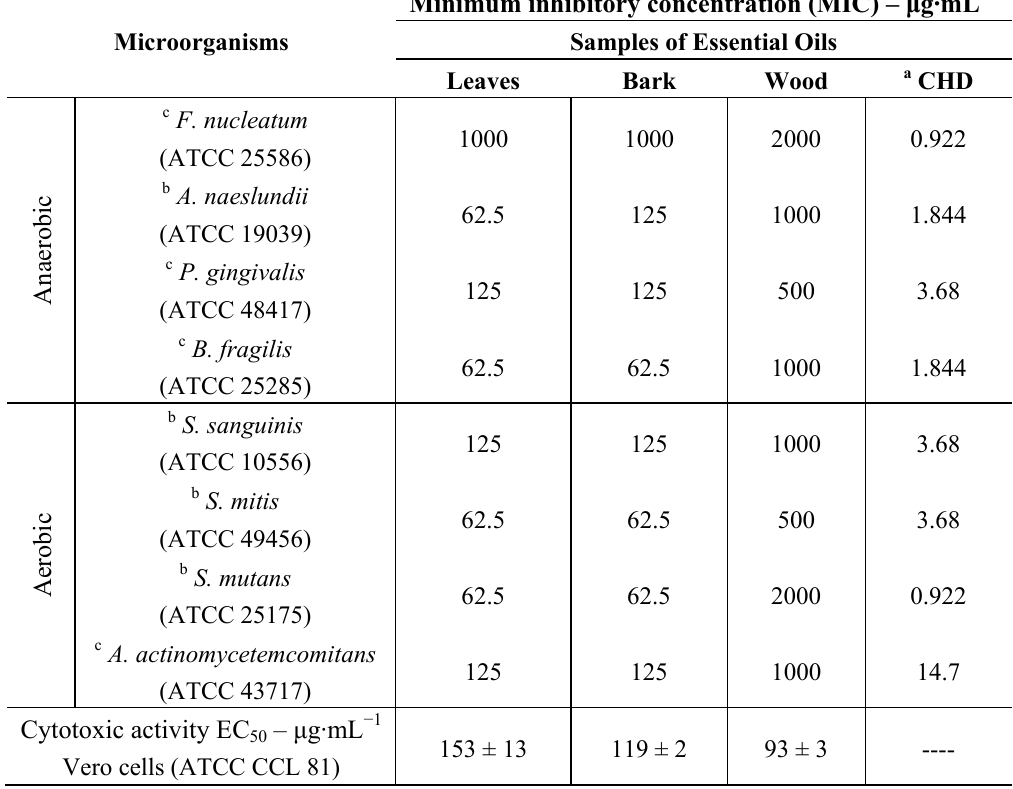
Table 3. Inhibitory effect of essential oils against aerobic and anaerobic oral bacteria and cytotoxic activity of different parts of C. bakeriana